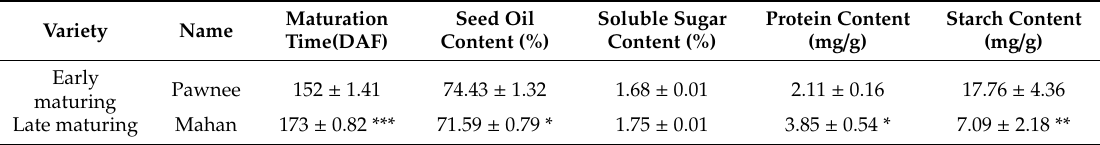
Table 1. Characteristics of Pawnee and Mahan varieties of pecan.